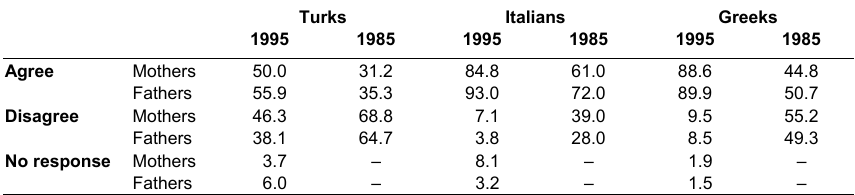
Table 2: Attitudes of foreign parents to marriages of their children with Germans, according to nationality and gender in 1985 and 1995 (percentages) Turks Italians Greeks 1995 1985 1995 1985 1995 1985 Agree Mothers